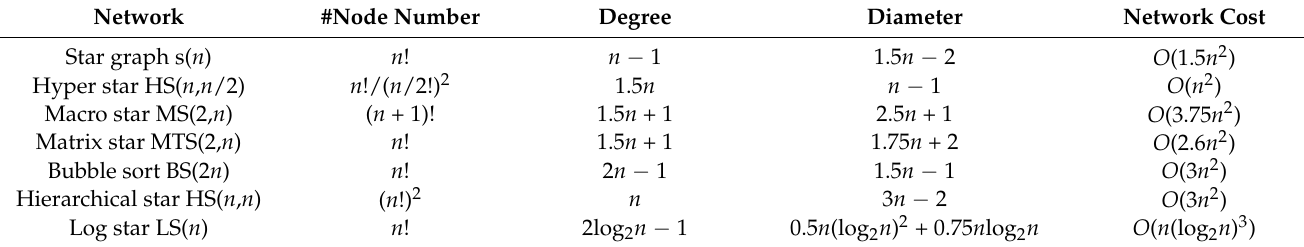
Table 1. Network cost comparison of LS n with other star graph-like